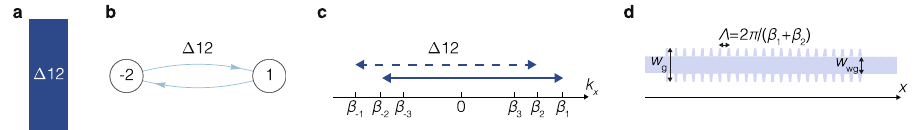
Fig. 5 | The different visualizations and design considerations of cascaded- mode resonators. a The visualization of a mode-converting mirror, re fl ecting mode 1 inmode-2,and vice-versa,used in the schematic inFig. 1. b The equivalent graphrepresentationofthismode-convertingmirror,alsousedinFig.1. c Inspatial frequency domain, the mode-converting mirror bridges the distance between the